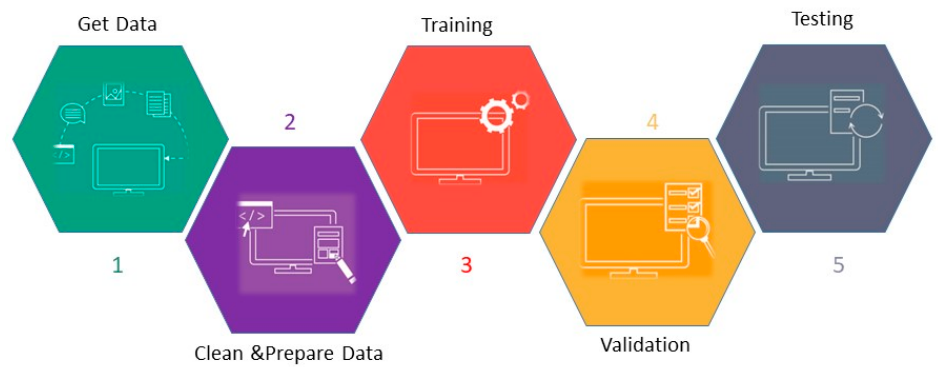
Figure 2. Five stages of the proposed methodology.